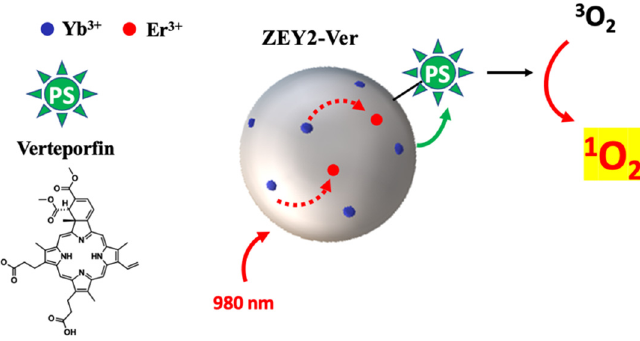
Figure 10. Pictorial representation of the photodynamic activity of Ver triggered by upconversion.